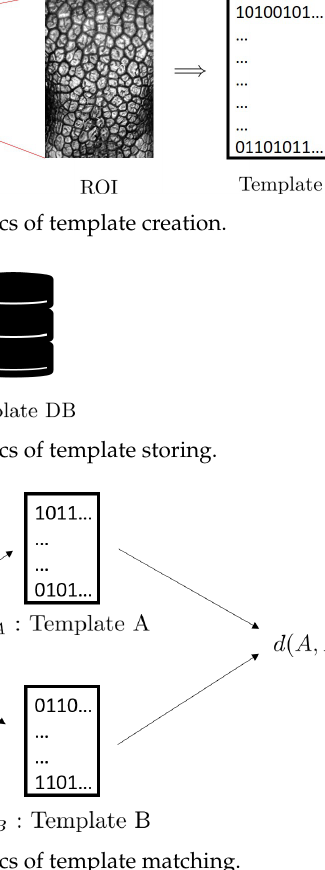
Figure 4. Schematics of template